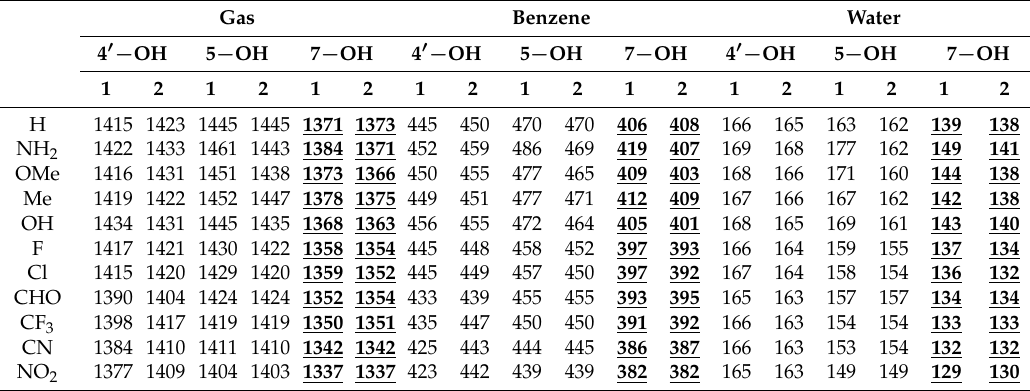
Table 4. Proton affinity (PA) in kJ/mol obtained by the M062X/6-311 + G** method a . Gas Benzene